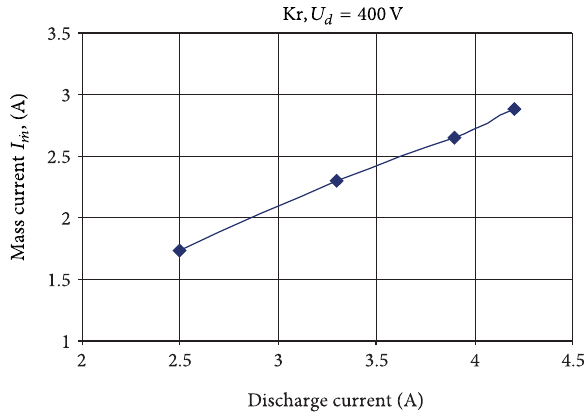
Figure 4: ATON A-3 mass current 𝐼 ̇𝑚 versus discharge current for 𝑈 𝑑 of 400 V in operation on Kr.